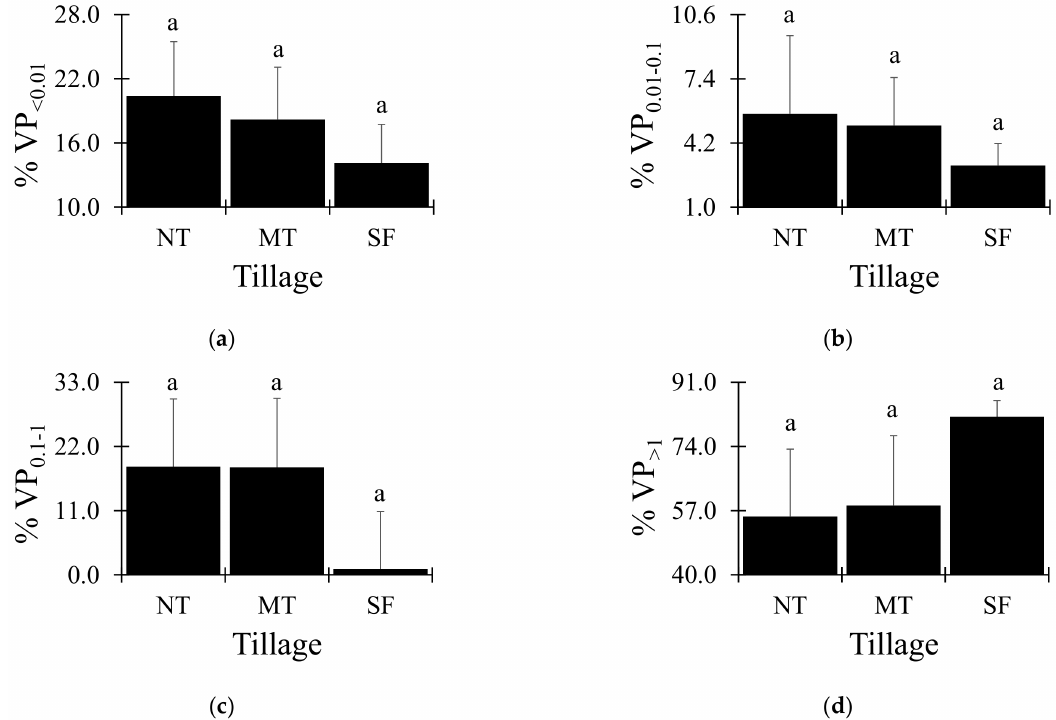
Figure 4. Pore volume distributions within the following classes: ( a ) <0.01 mm 3 , ( b ) 0.01 to 0.1 mm 3 , ( c ) 0.1 to 1 mm 3 , and ( d ) >1 mm 3 for soil aggregates from no tillage (NT), minimum tillage (MT), and secondary forest (SF). Vertical bars represent the standard error ( n = 6). Different letters represent significant differences among management practices (Tukey’s HSD; p <